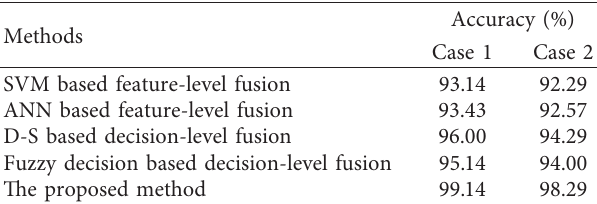
Figure 10: Classification results by vibration signals at different measuring Points: (a) V1, (b) V2, (c) V3, and (d) V4. Table 1: Comparison of test accuracy from different diagnostic